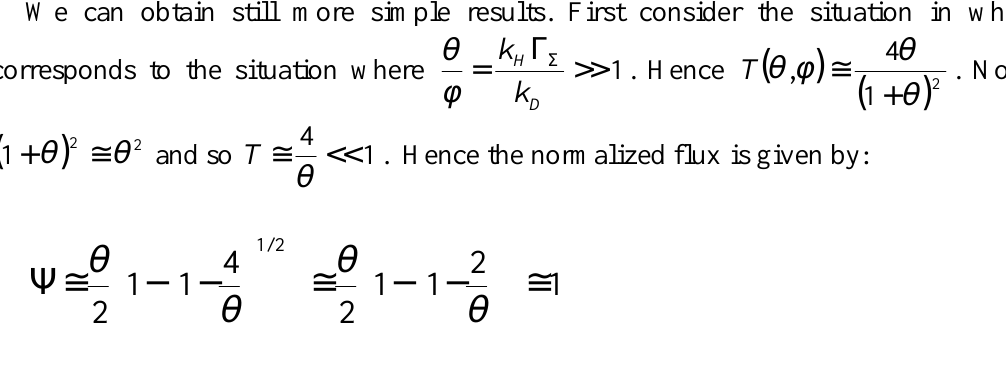
φθθ 4 ( ) φθ ++= T with θ and φ , ( ) 2 1